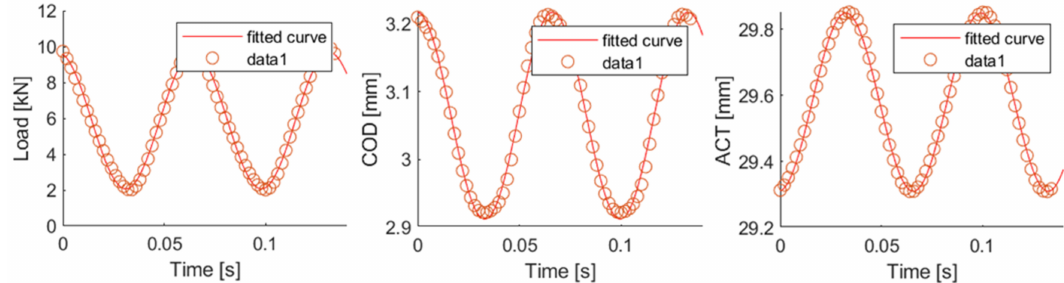
Figure 6. Data fitting.